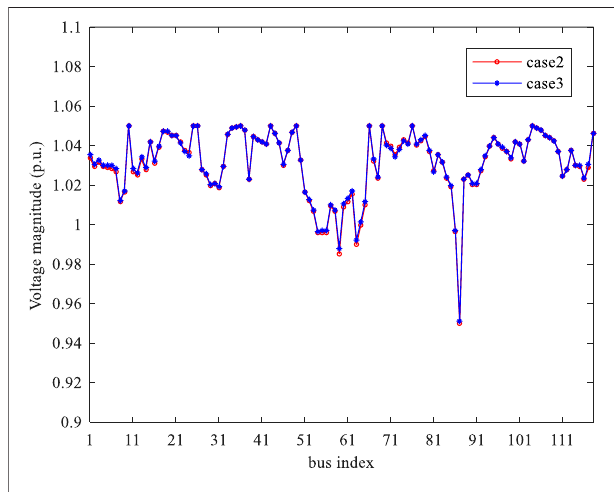
FIGURE 7 | Comparison of apparent power. FIGURE 8 | Comparison of voltage.